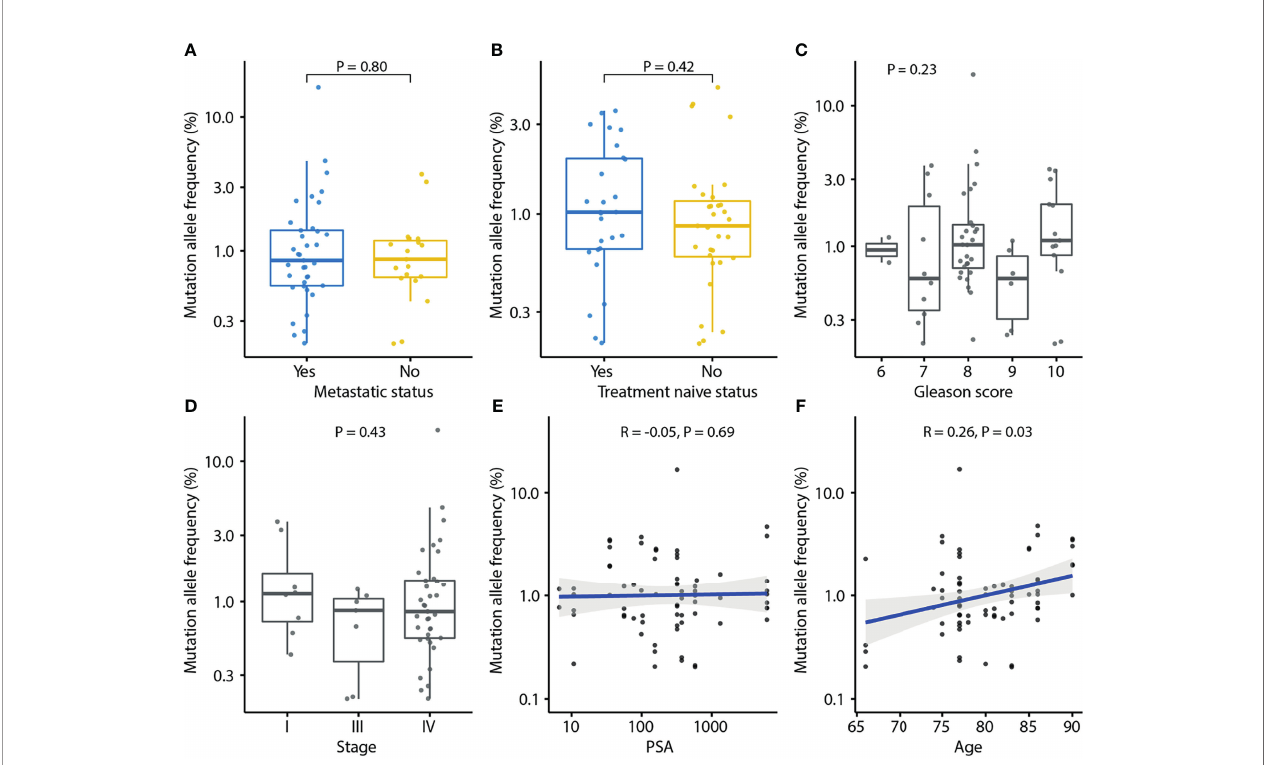
FIGURE 5 | Association of mutation allele frequency (MAF) detected in urine cfDNA and clinical characteristics of prostate cancer. Each dot indicates one sample. (A) Association of MAF and metastasis status. P-value was calculated by the Mann-Whitney U test. (B) Association of MAF and treatment naïve status. P-value was calculated by the Mann-Whitney U test. (C) Association of MAF and Gleason score. P-value was calculated by the Kruskal-Wallis test. (D) Association of MAF and tumor stage. P-value was calculated by the Kruskal-Wallis test. (E) Association of MAF and PSA. Spearman ’ s rank correlation coef fi cient and the corresponding P- value are shown. (F) Association of MAF and age. Spearman ’ s rank correlation coef fi cient and the corresponding P-value are shown. Each dot indicates one